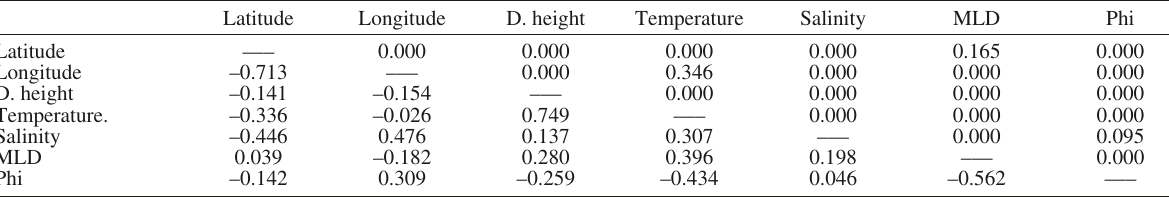
Table 1. – Correlation matrix for spatial (longitude and latitude) and environmental factors [temperature and salinity (50 m depth); dynamic height; mixed layer depth (MLD); and water column stratification (Phi)]. Lower diagonal are Pearson’s correlation coefficients, upper diago- nal are p